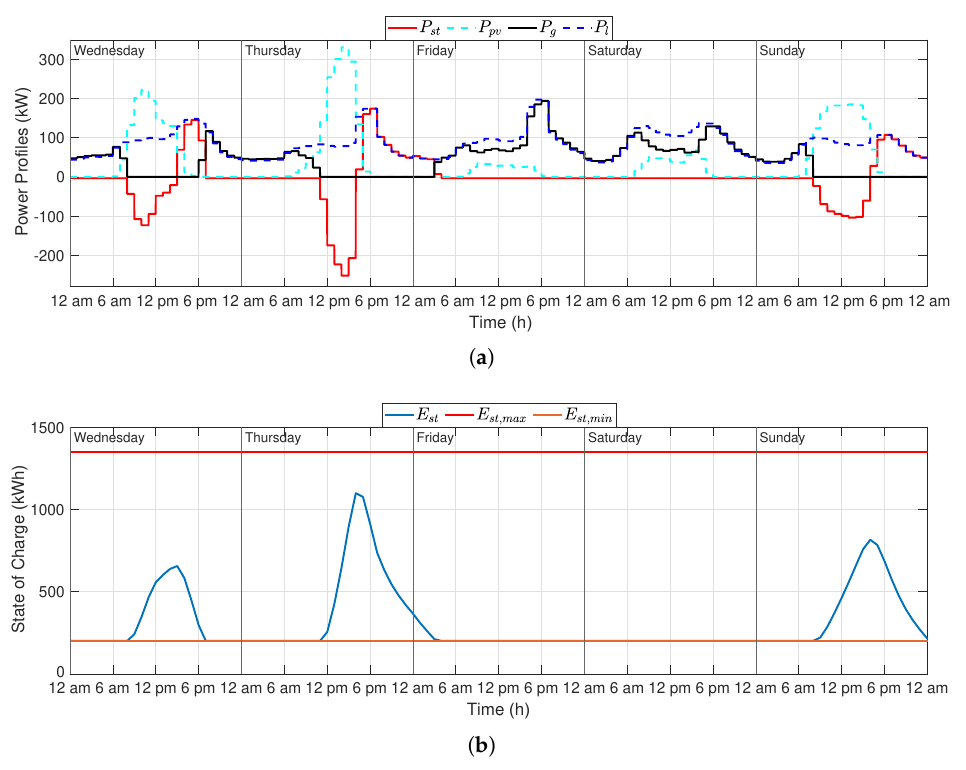
Figure 10. Heuristic approach results in a simulation of five days: ( a ) Power Profiles; ( b ) State of Charge.